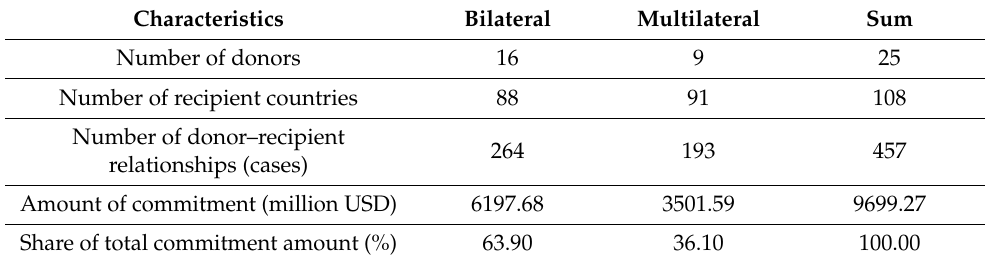
Table 3. Overview of bilateral and multilateral REDD+ finance